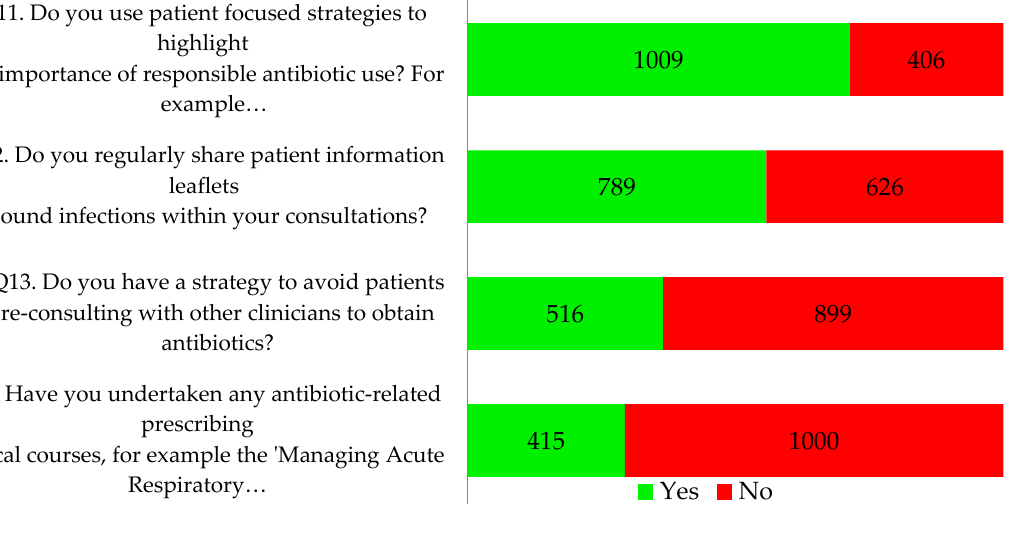
Figure 5. What all antibiotic aware practices should be doing.